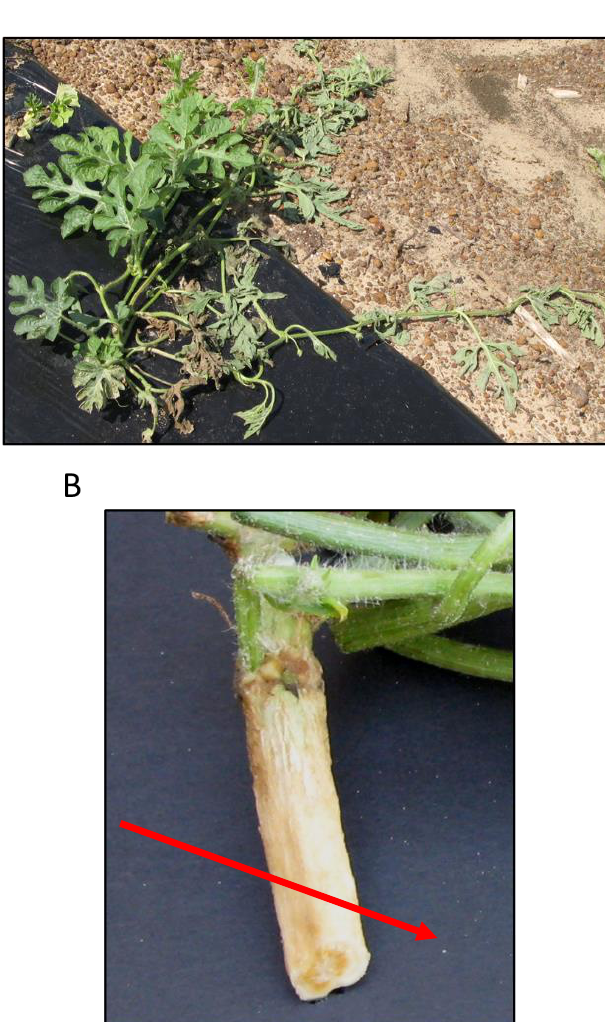
Figure 1. Fusarium wilt symptoms ( A ) in the field, and ( B ) in the vasculature (arrow). Three main spore types exist for Fusarium oxysporum f. sp. niveum : microconidia, macroconidia (Figure 2), and chlamydospores. Chlamydospores are the primary infective propagule that survive from one season to the next. They arise from both hyphae and from groups of macroconidia forming sporodochia. Chlamydospores are formed in times of stress when nutrients for survival run low and germinate when they detect an increase of nutrients from plants or seeds. Not only do chlamydospores often provide the initial infection on the watermelon host, but can also survive for up to a decade or longer in the soil [15–17]. Once a chlamydospore detects plant exudates, the spore germinates. The root exterior is then colonized by the chlamydospore hyphae which occurs on both host and nonhost